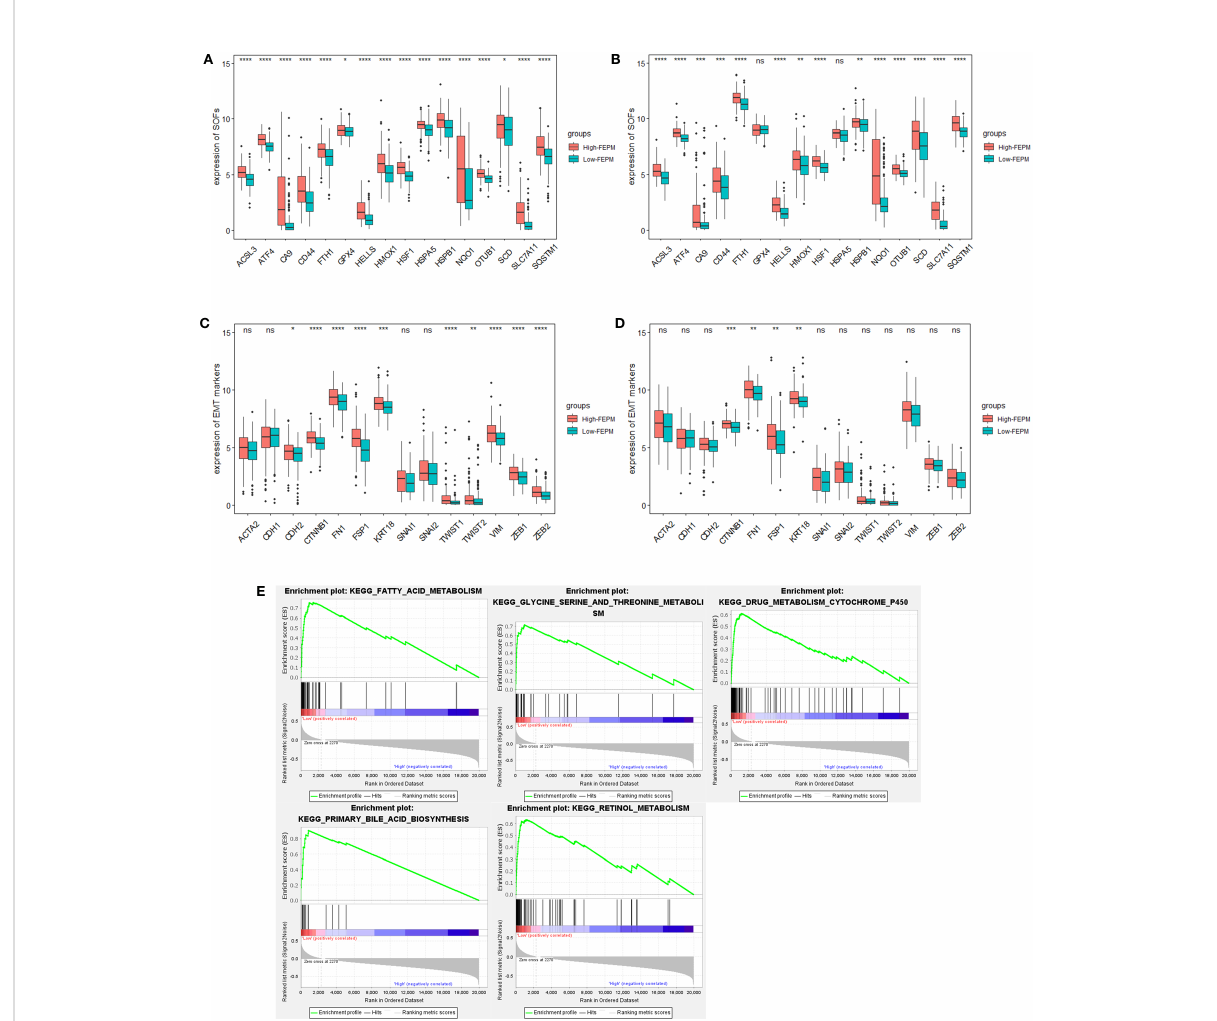
FIGURE 6 Analysis of Ferroptosis and EMT status. (A, B) Boxplots showing the expression pro fi les of SOFs in the TCGA and ICGC cohorts. (C, D) Boxplots showing the expression pro fi les of EMT markers in the TCGA and ICGC cohorts. (E) Pathways enriched in the low-FEPM group in the TCGA cohort. * p< 0.05; **p< 0.01; ***p< 0.001; ****p< 0.0001; ns, not signi fi